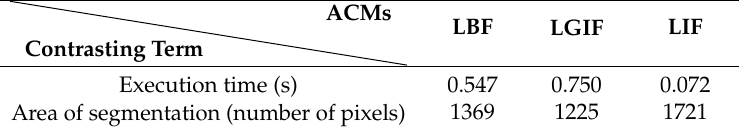
Figure 19. Results of various ACMs. ( a ) Pre-set contour; ( b – d ) LBF, Local and Global Intensity Fitting (LGIF), and Local Image Fitting (LIF) model results, respectively. Table 3. Contrasting terms of di ff erent Active Contour Models